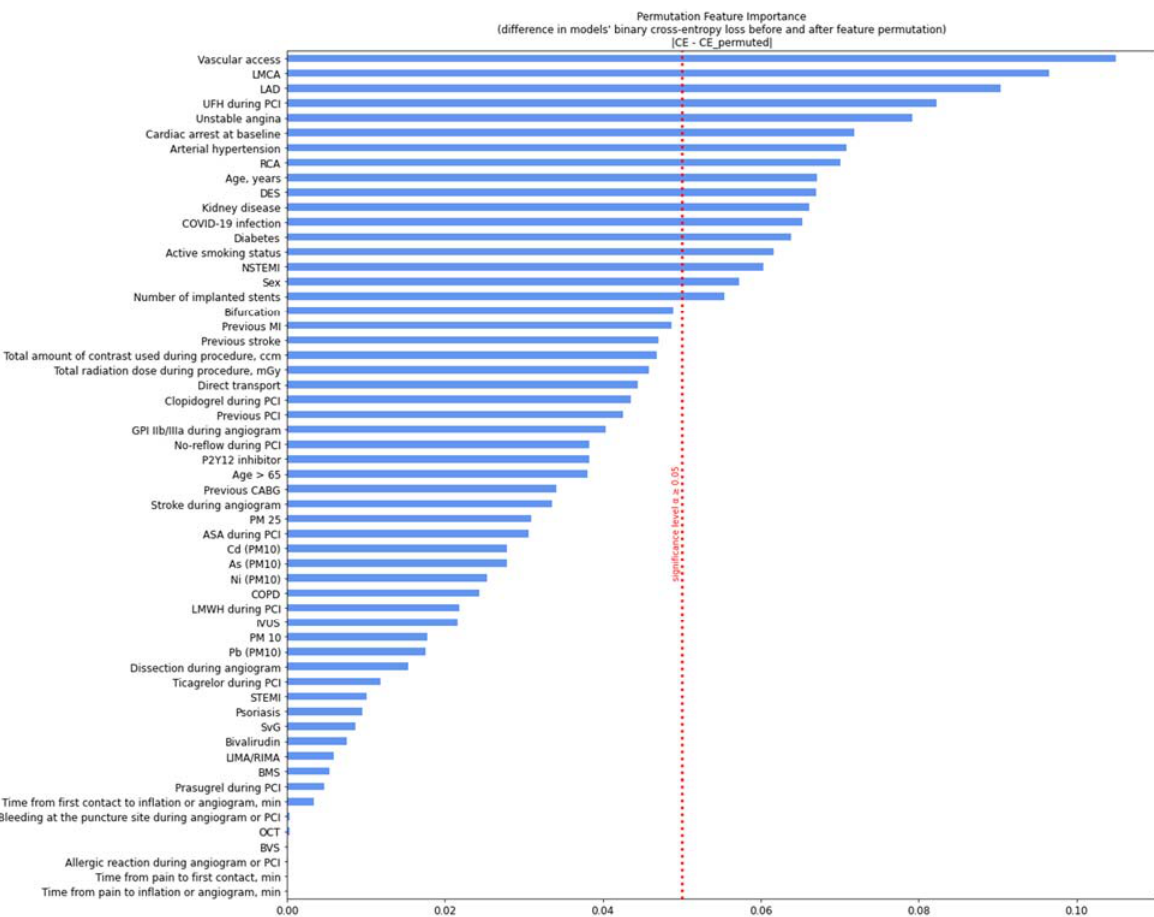
Figure 5. Variables and their impact on the network model based on permutation